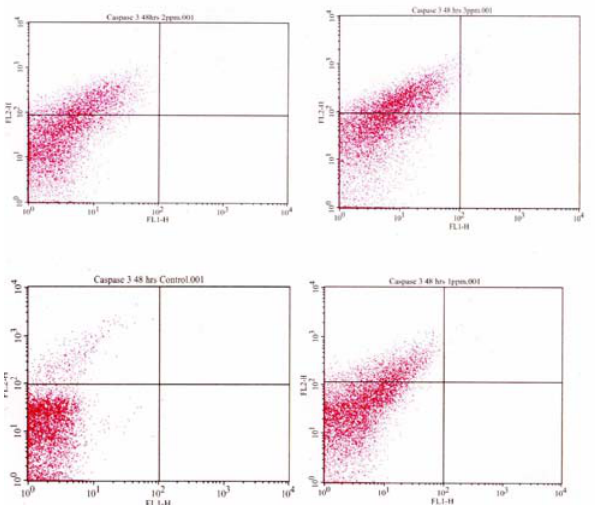
Figure 3: Flow cytometric analysis of Caspase 3 activity cells exposed to mercury. in HepG 2